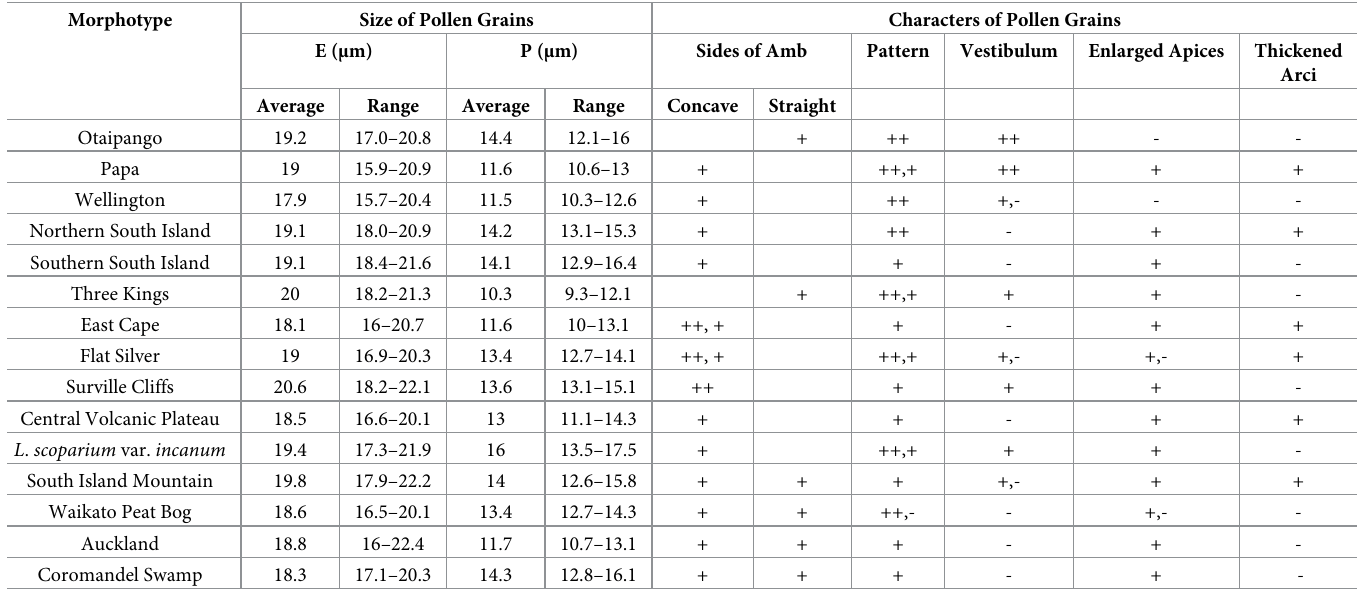
Table 1. Pollen morphological characters of Leptospermum scoparium s.l. morphotypes (visual